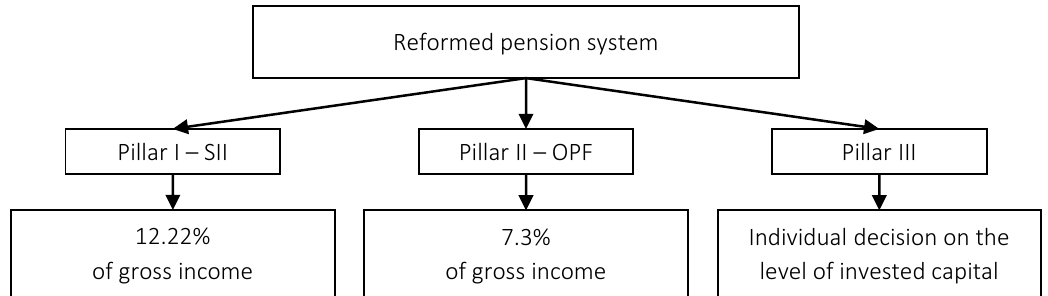
Figure 1. Architecture of the reformed pension system in Poland – condition in the timing of the pension